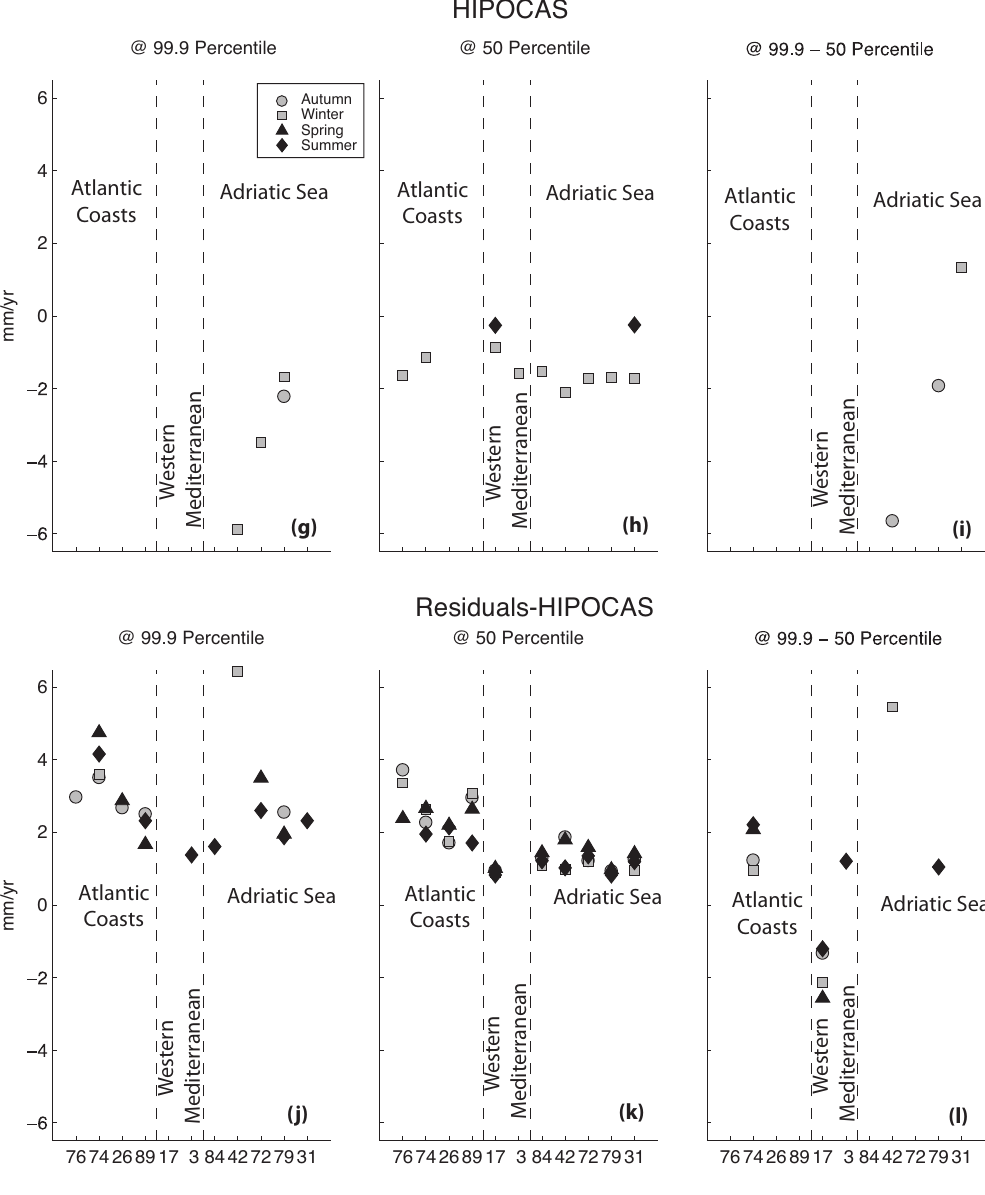
Figure 6. Significant trends in the 99.9 and 50 percentiles and their differences. (a-c) for the observed values; (d-f) for the tidal residuals; (g-i) for the model values; (j-l) for the corrected by the model tidal